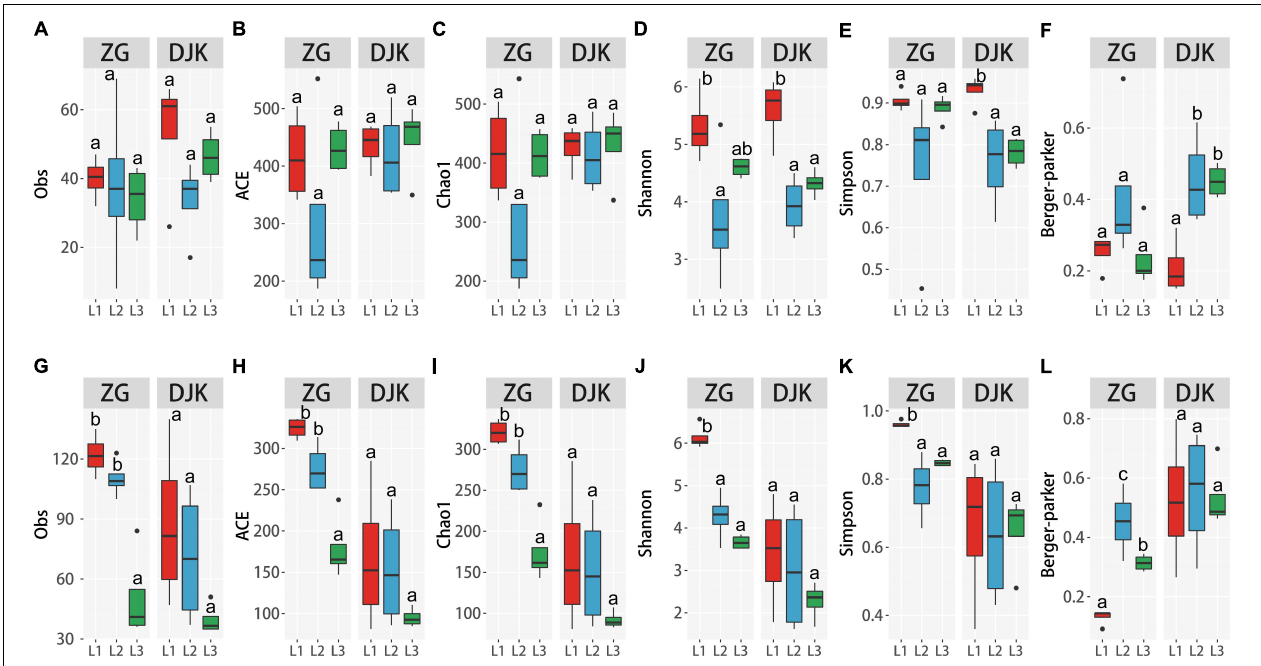
FIGURE 3 | Alpha diversity of microbiota across different development stages of larvae. (A–F) Alpha diversity of bacteria among the three development stages of larvae according to the Obs, ACE, Chao1 and Shannon, Simpson and Berger-Parker index ( n = 4). (G–L) Alpha diversity of fungi among the three development stages of larvae, as measured as Obs, ACE, Chao1, Shannon, Simpson and Berger-Parker index ( n = 4). Multiple comparisons were performed in the two groups separately. Different letters indicate a significant difference between different instars in each group ( p < 0.05, one-way ANOVA, Tukey post hoc